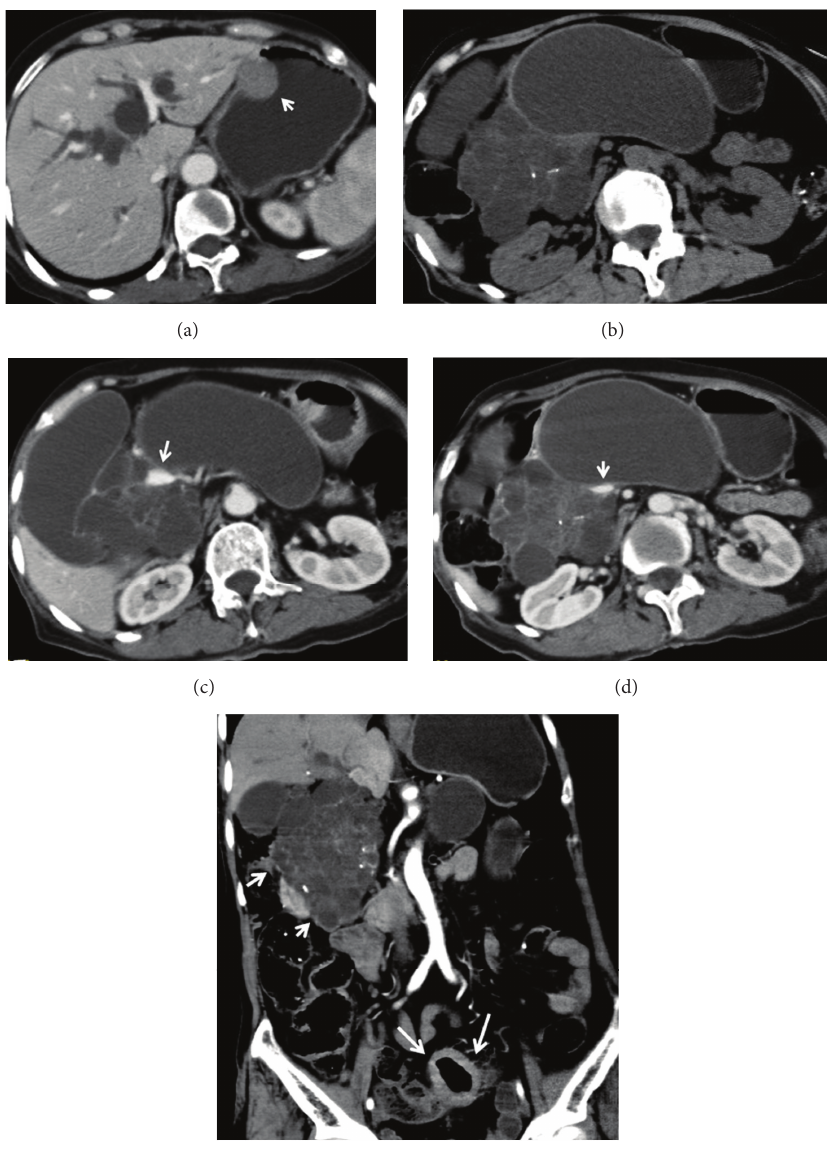
Figure 3: A 68-year-old female patient with a giant serous cystadenoma of the pancreatic head, concurrent colorectal cancer, and gastric stromal tumor. (a) Intrahepatic bile duct dilation and a gastric stromal tumor (arrow) were detected on CT plain scanning. (b) The pancreatic head tumor showed honeycomb-like appearance with multiple macrocysts and punctuate calcification. ((c) and (d)) Encasement of the portal and superior mesenteric veins (arrow) was noted on portal phase image. (e) The coronal CT image showed a pancreatic head tumor (short arrow) and rectal mass (long